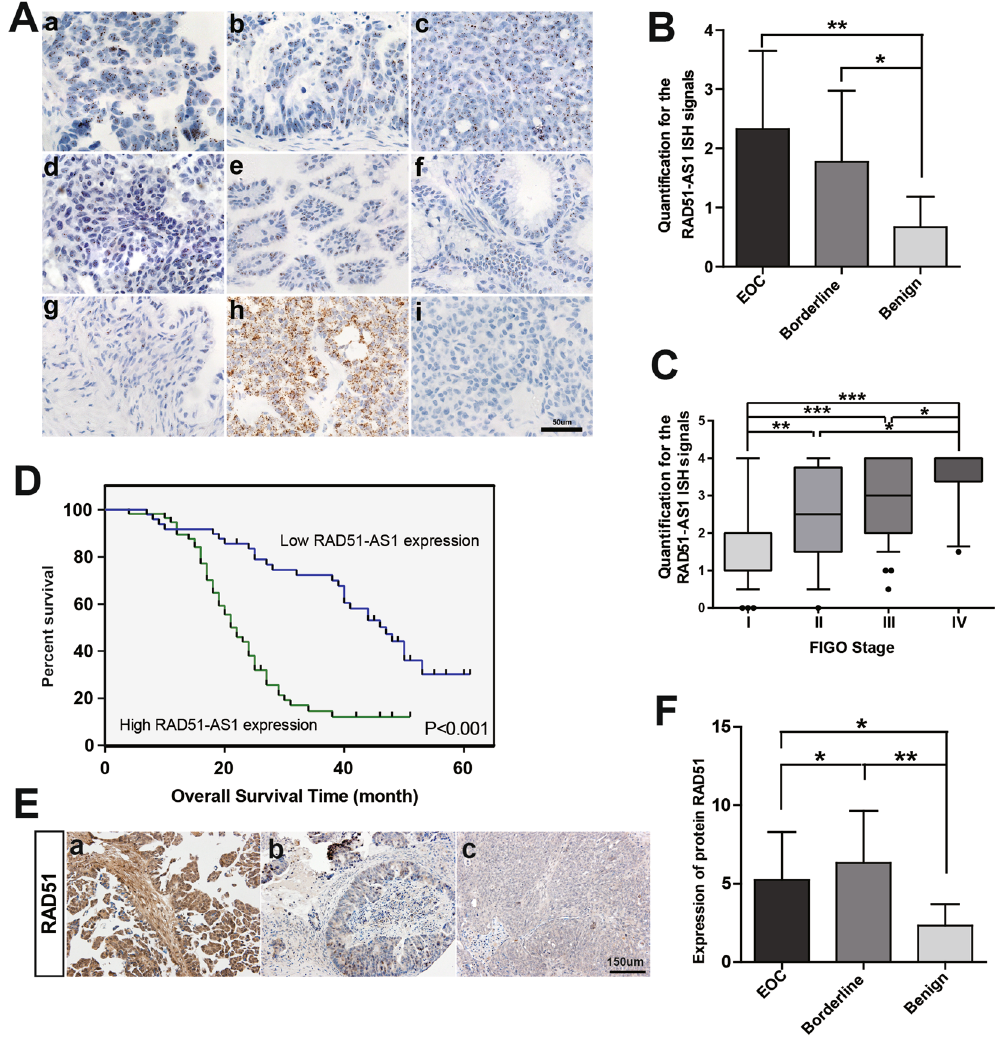
Figure 1. High expression of RAD51-AS1 correlated with poor prognosis in EOC. ( A ), Representative images of ISH for RAD51-AS1 in patient samples. a–d, EOC (a, serous. b, mucinous. c, endometrial. d, clear cell carcinoma). e and f, borderline ovarian tumor (e, serous. f, mucinous). g, benign ovarian tumor. h, positive control. i, negative control. ISH of a-g was performed using RAD51-AS1 target probes. ISH of h and i was performed using positive and negative probes, respectively. ( B ), Semi-quantitative analysis of ISH data of RAD51-AS1 expression in EOC (n = 129), borderline ovarian tumors (n = 22) and benign ovarian tumors (n = 12). (Mann-Whitney test) ( C ), Semi-quantitative analysis of ISH data of RAD51-AS1 expression in EOC samples of different grades. Grade I (n = 47), grade II (n = 21), grade III (n = 51) and grade IV (n = 10), (90% CI; Mann-Whitney test). ( D ), Kaplan-Meier analysis of OS was performed based on RAD51-AS1 expression levels (P < 0.001, log-rank test). ( E ), Representative images of IHC for RAD51 in patient samples. Figure 1E-a, b, c correspond to the same samples in Fig. 1A-a, b, c, respectively. ( F ), Analysis of protein RAD51 expression in EOC, borderline ovarian tumors and benign ovarian tumors (Mann-Whitney test). ( * P < 0.05; ** P < 0.01; *** P <